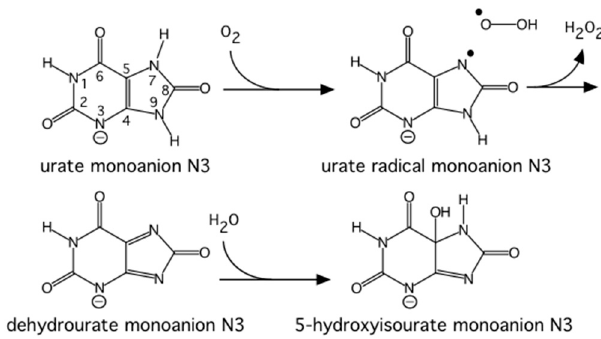
Figure 10. The reaction catalyzed by urate oxidase. Figure reproduced from [42].